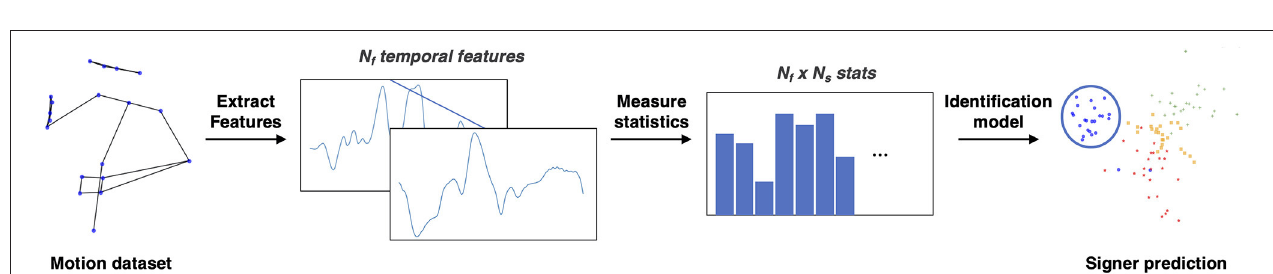
FIGURE 3 | Schematic representation of the steps used in the machine learning model for